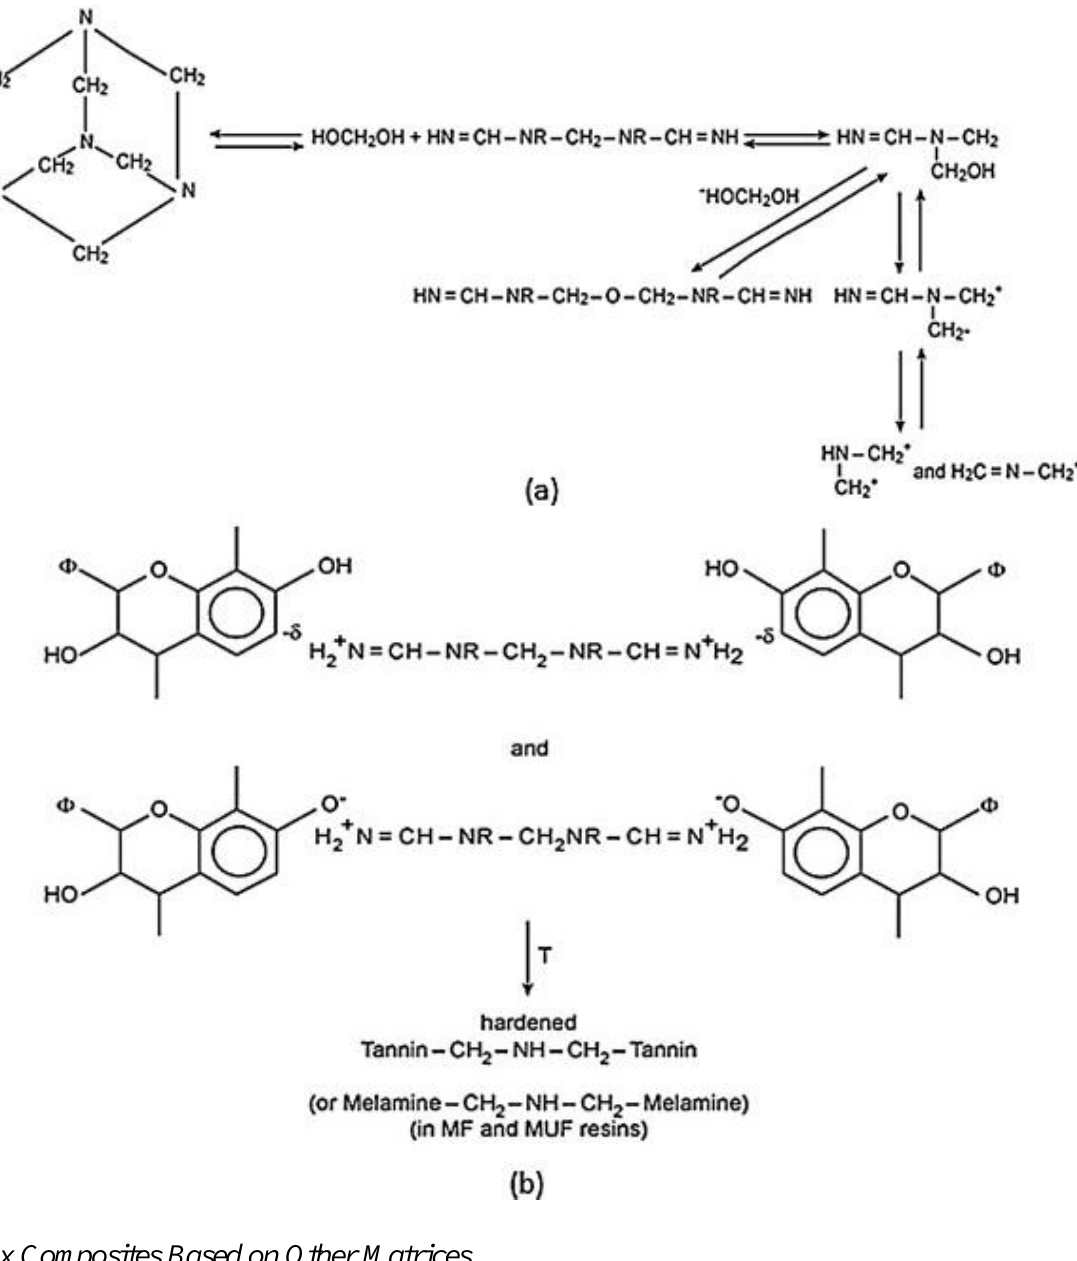
Figure 12. The chemical reaction between tannin and hexamine: ( a ) decomposition of hexamine; and ( b ) polycondensation of condensed tannin